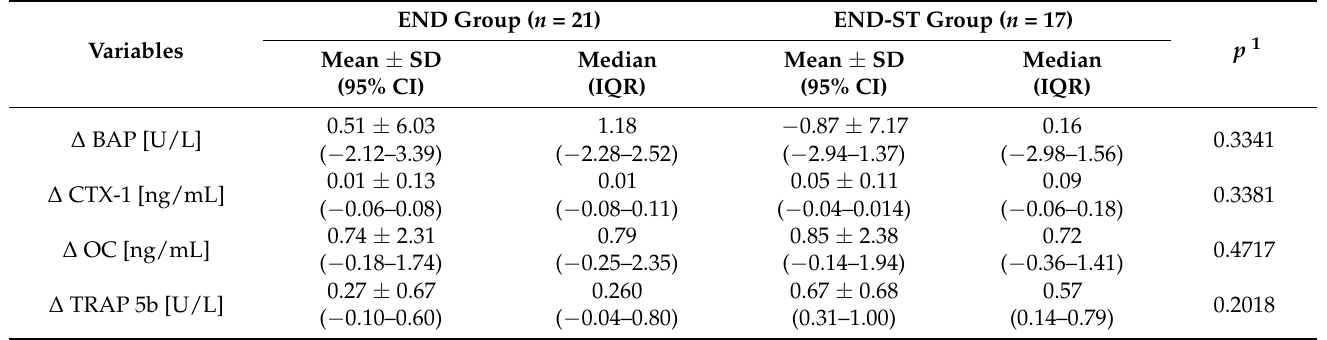
Table 5. Comparison of the differences ( ∆ ) in the effect of endurance and endurance-strength training on bone turnover marker